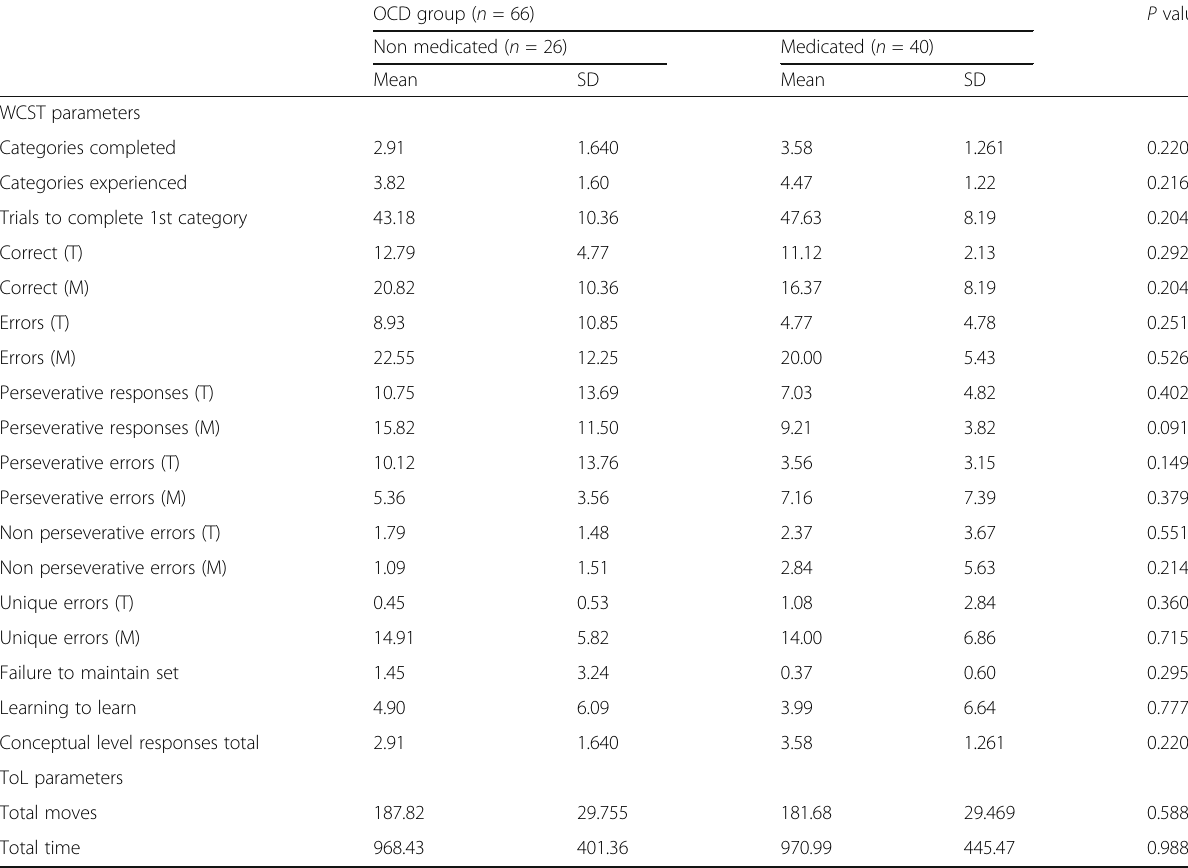
Table 6 Comparison of WCST and ToL parameters regarding medical treatment among OCD group ( n =